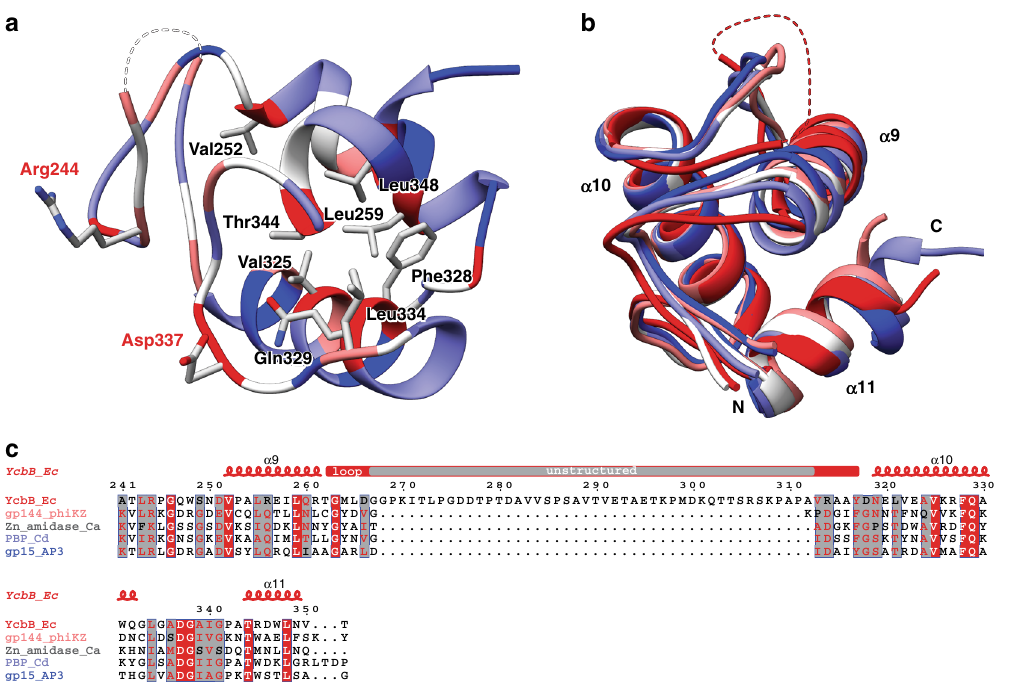
Fig. 2 Structure of the E. coli YcbB peptidoglycan binding domain. a Ribbon representation of the E. coli YcbB peptidoglycan binding domain, residues 241 – 351, with residue conservation mapped to backbone colour from red to blue in decreasing conservation. Conserved core residues labelled in black and key, surface exposed, peptidoglycan binding residues labelled in red. b Overlay of YcbB peptidoglycan binding domain and high scoring peptidoglycan binding domains from a structural homology search on the Dali server 14 . YcbB in red, gp144, a Pseudomonas aeruginosa phage phiKZ endolysin in salmon (PDB ID 3BKH 15 ), a Clostridium acetobutylicum zinc-dependent amidase in white (PDB ID 4XXT), a Clostridium dif fi cile PBP in pale blue (PDB ID 5TV7), and gp15, a Burkholderia AP3 phage endolysin in dark blue (PDB ID 5NM7 11 ). Peptidoglycan binding domain structures are coloured from red to blue based on decreasing structural homology. c The sequence of E. coli YcbB (YcbB_Ec) aligned with peptidoglycan binding domains from phiKZ gp144 (gp144_phiKZ), displayed atop the sequence alignment, with the extended loop shown in red and the unstructured region in